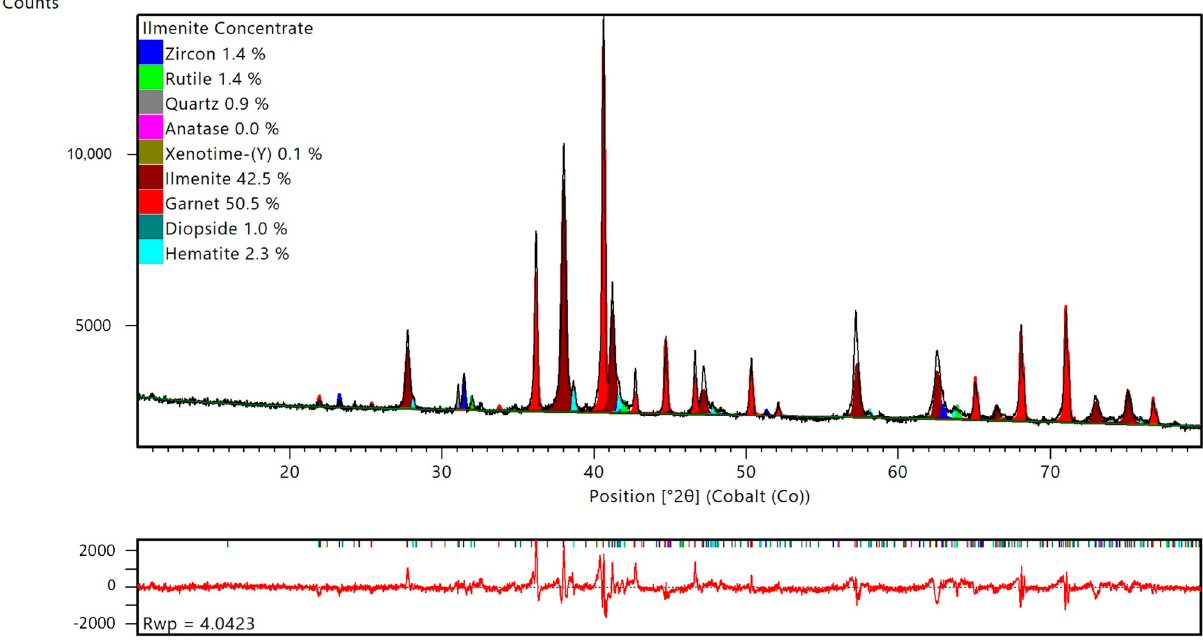
Figure 6. Typical ilmenite concentrate. Rietveld quantification ( top ) including difference plot between measured and calculated profiles, as well as the R wp ( bottom ).